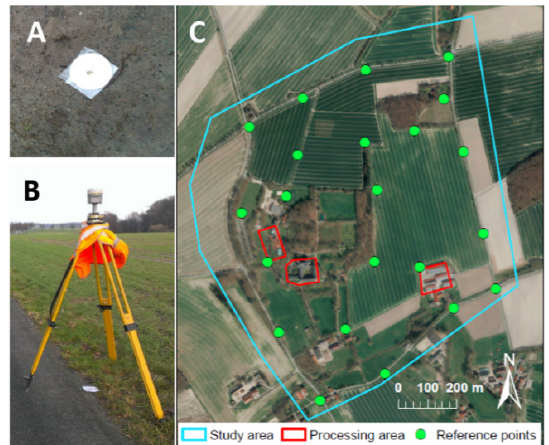
Figure 2: Ground reference points. A: shape, B: means of measurement, C: distribution of reference points and selected processing areas for point-to-plane